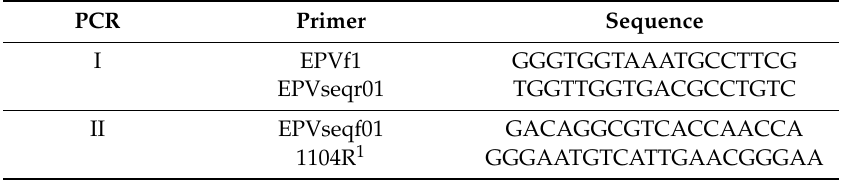
Table 1. Primer positions and sequences used for sequencing analysis.